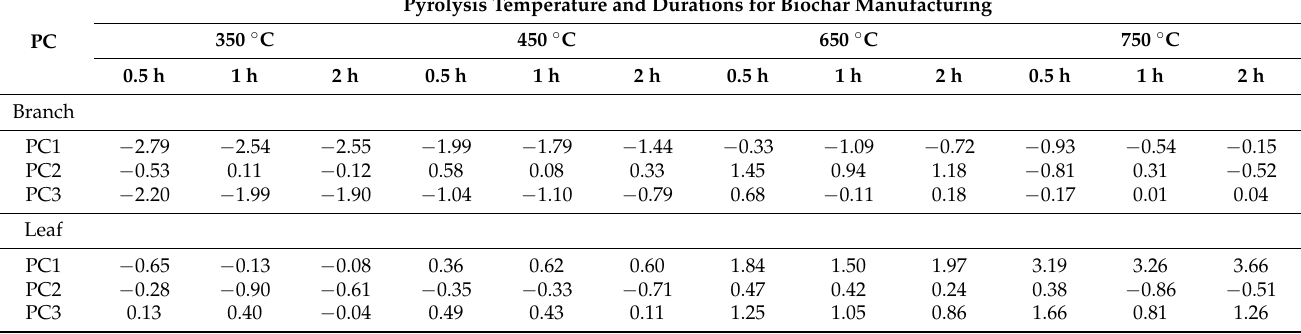
Table 5. Scores in three principal components for 24 types of